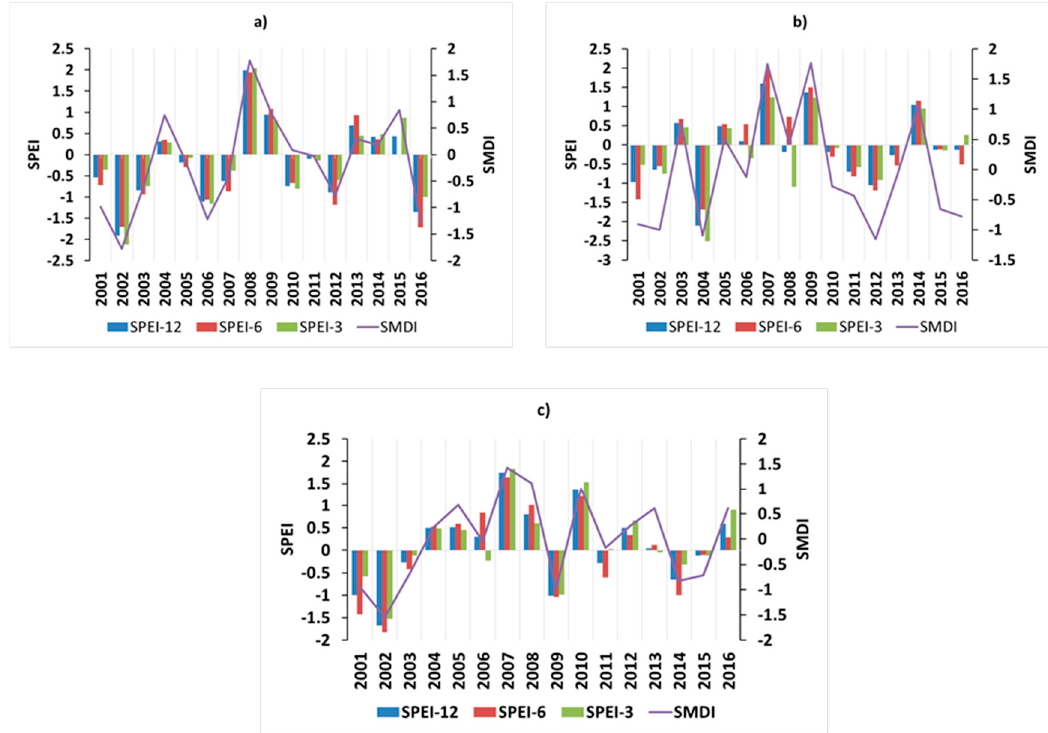
Figure 16. Annual variability of SMDI in relation to SPEI: ( a ) SOS, ( b ) LOS, and ( c ) EOS.